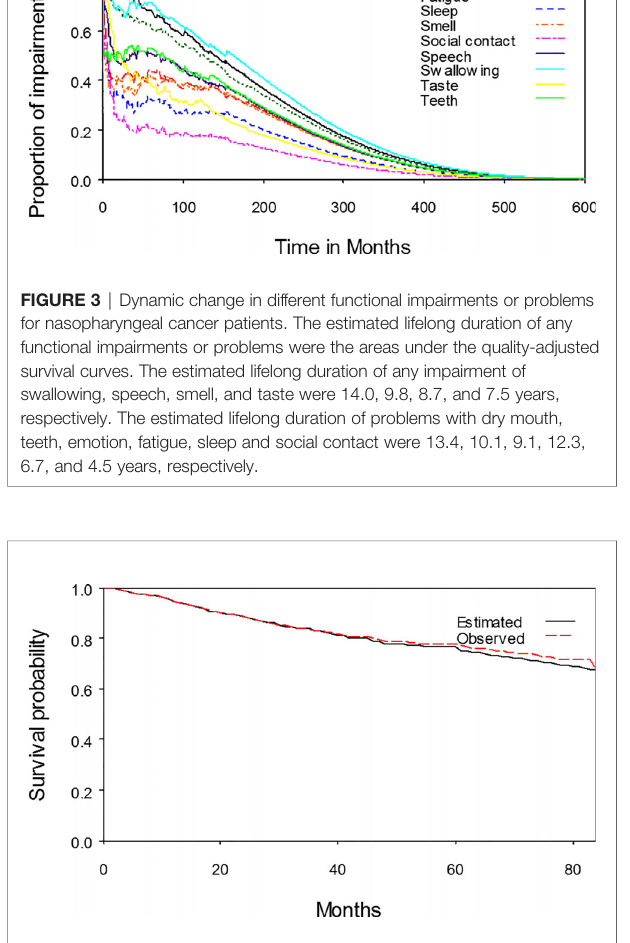
FIGURE 4 | The estimated 7-year survival curve and the observed 7-year survival curve matched suf fi ciently.